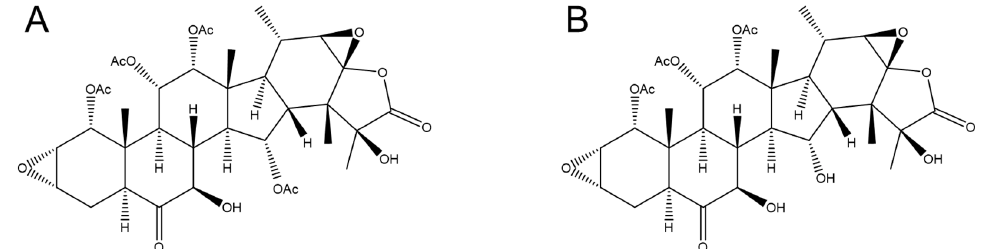
Figure 1. Chemical structures of the C-22,23-epoxytaccalonolides, AF ( A ) and AJ ( B ). Once we identified the SK-OV-3-MDR-1-6/6 and NCI/ADR-RES cell lines as MDR1- expressing ovarian cancer models, we assessed the potency and efficacy of taccalonolide AF in these lines and their respective isogenic parental lines using the sulforhodamine B assay. We determined the concentration of AF or paclitaxel that inhibited growth by 50% (GI 50 ) in each cell line and calculated relative resistance values by dividing the potency in each MDR1 -expressing line by its potency in the respective parental line (Table 1). While NCI/ADR-RES cells were over 870-fold resistant to paclitaxel as compared to the parental OVCAR-8 line, they were only 124-fold resistant to AF (Table 1) suggesting AF is less susceptible to Pgp-mediated resistance as compared to paclitaxel. These results were con- sistent in the other cell line pair where the SK-OV-3-MDR-1-6/6 line was 90-fold resistant to paclitaxel but only 11-fold resistant to AF (Table 1). Similar results were obtained when